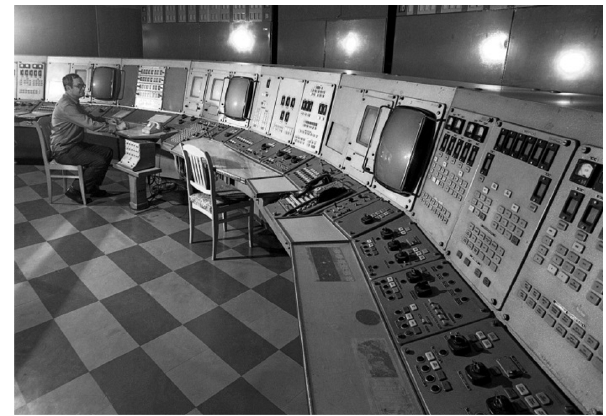
Figure 5. The Dnepr radar control room (1990s).